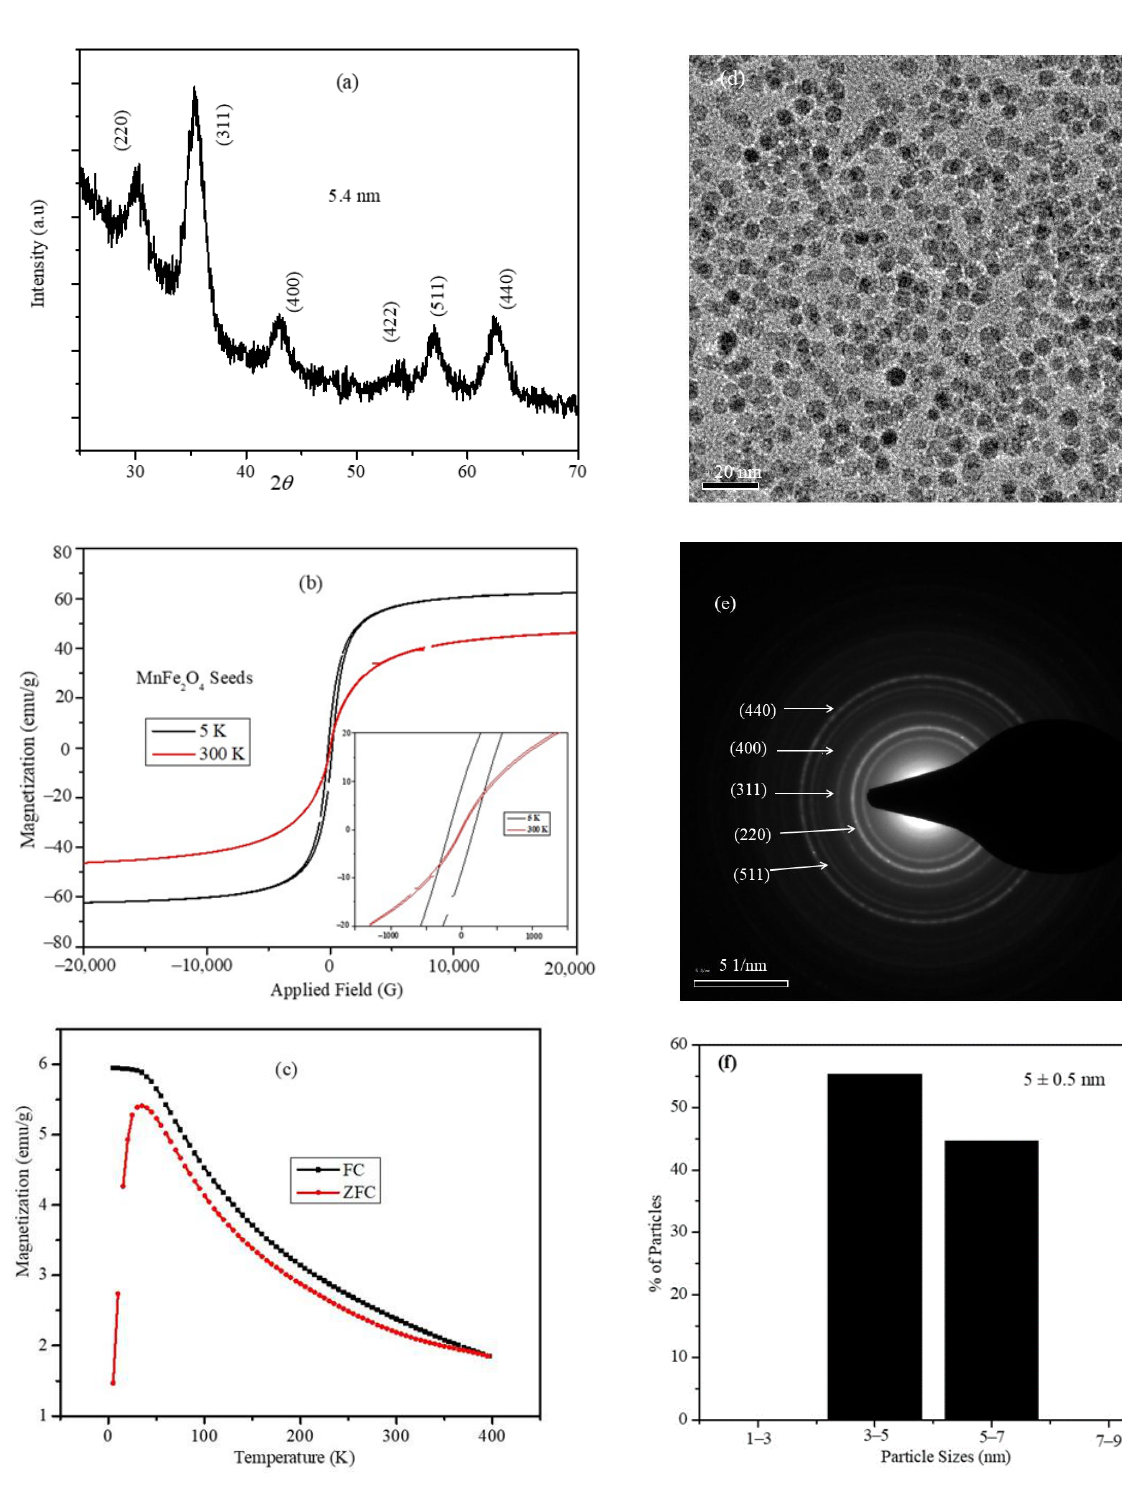
Figure 1. ( a ) XRD pattern, ( b ) field-dependent magnetization hysteresis loops at 5 and 300 K, ( c ) ZFC and FC temperature-dependent magnetization plots, ( d ) bright-field TEM image, ( e ) SAED pattern, and ( f ) size distribution of the MnFe 2 O 4 nanoparticles.